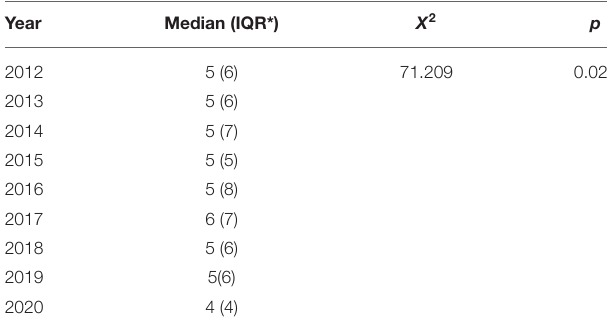
TABLE 6 | Hospitalization days between 2012 and 2020.